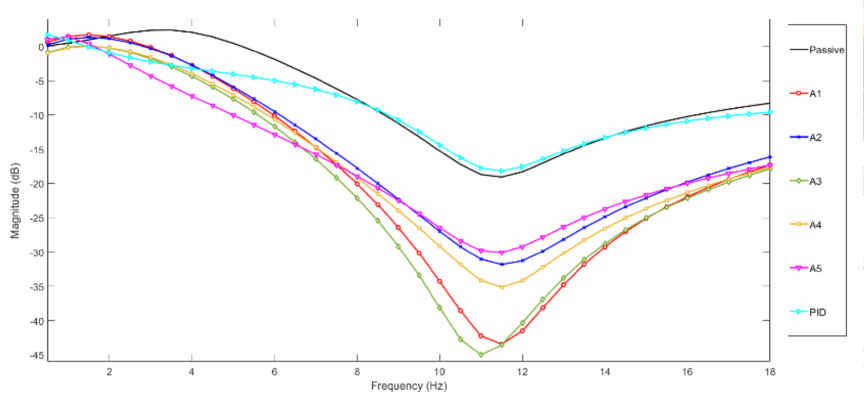
Figure 3. Simulated frequency responses of the passive and active seat suspensions.